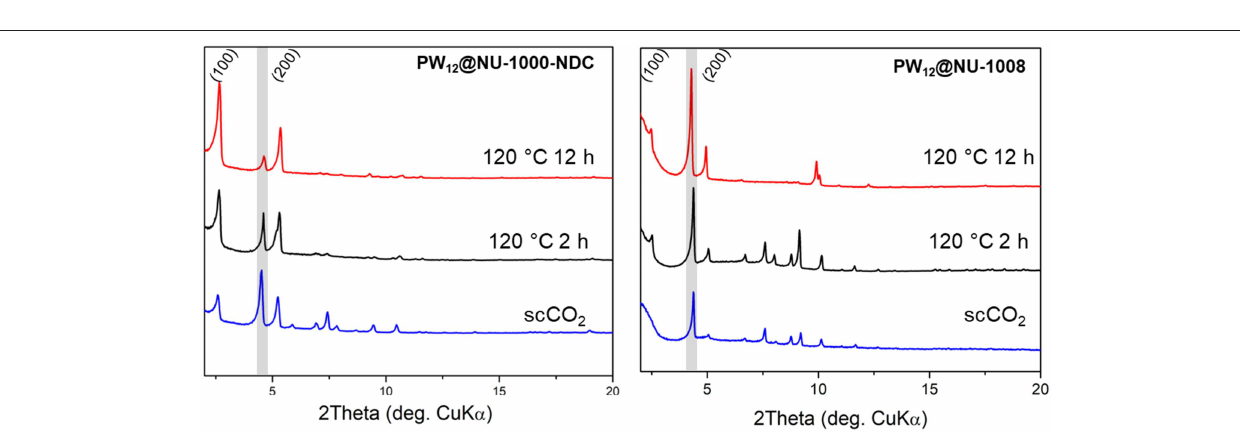
Aldrich and used as received. All gases for activation and quantification were Ultra High Purity Grade